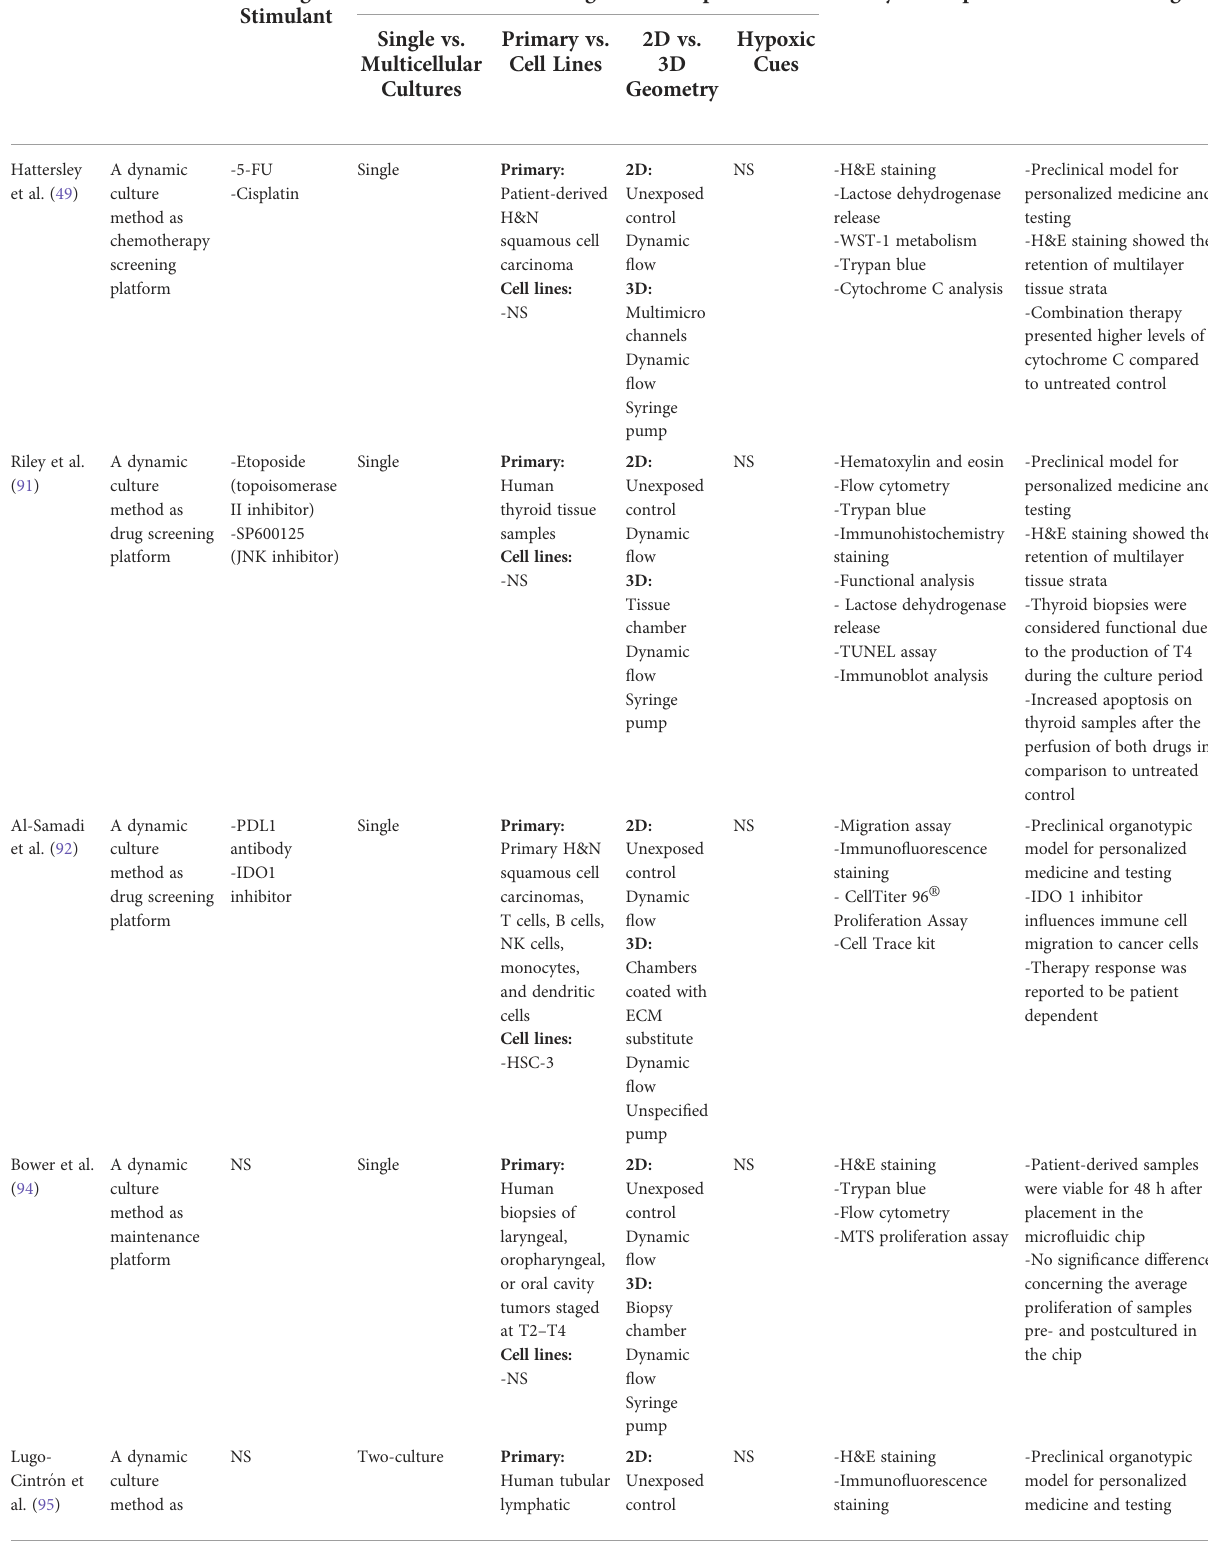
TABLE 3 Micro fl uidic Devices in H&N Cancer